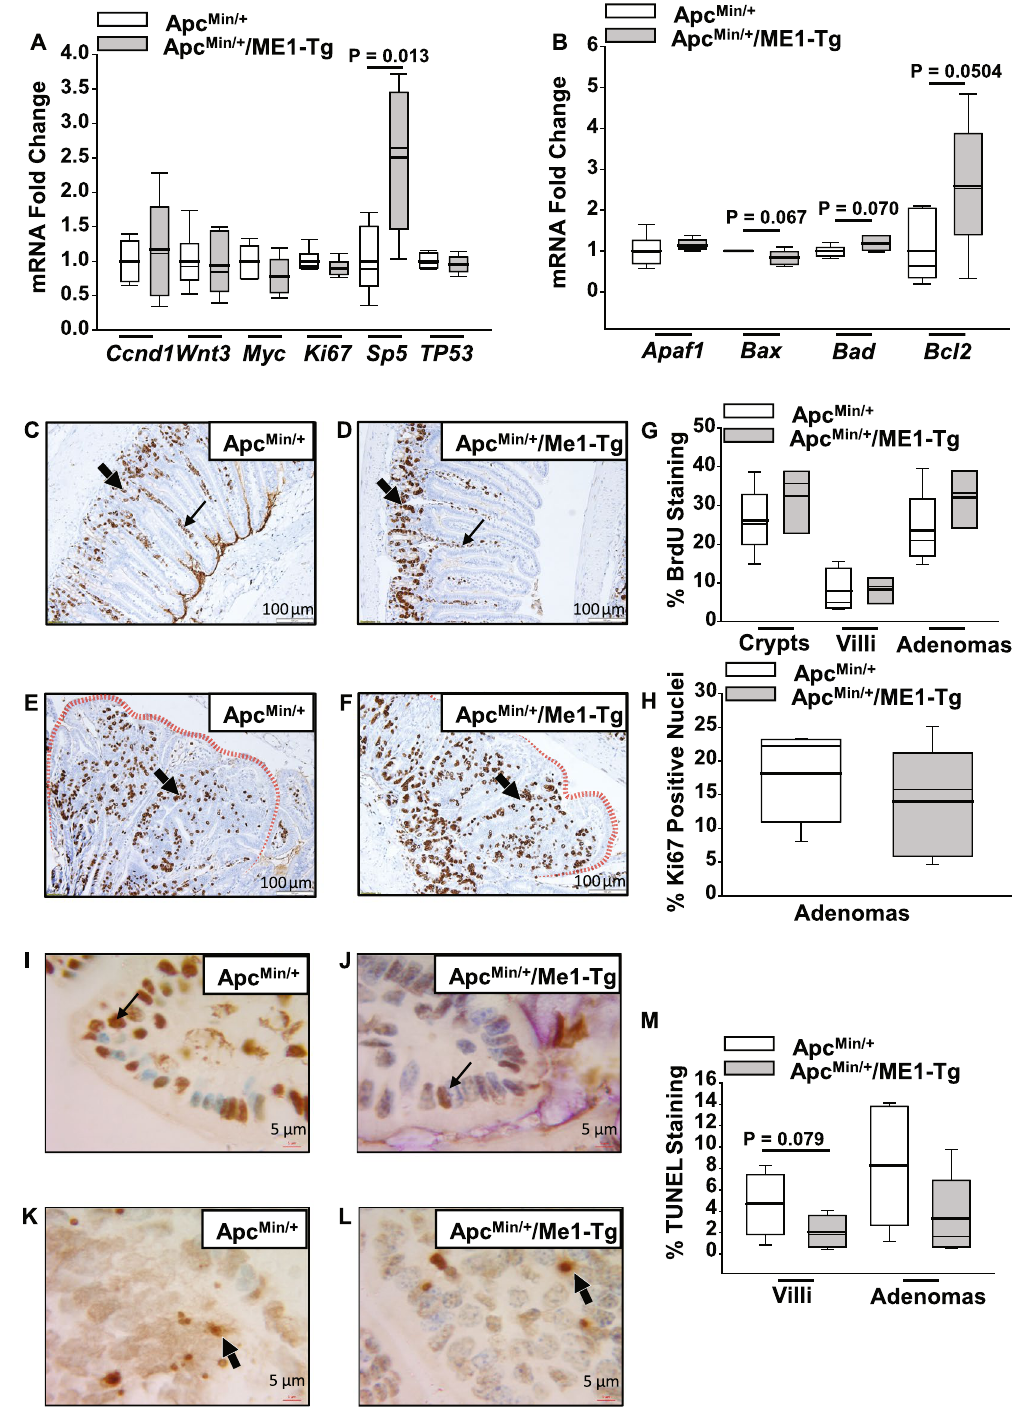
Figure 4. Gene expression, proliferation and apoptosis in experimental mice. ( A ) Fold change of abundance of mRNAs encoding oncogenes and tumor suppressors in jejunums of Apc Min/ + and Apc Min/ + /ME1-Tg male mice (n = 5–6/group). ( B ) Fold change of mRNAs encoding apoptosis-related proteins in mouse jejunums (n = 5–6 mice/group). ( C,D ) Representative images of BrdU-labeled crypts and villi in ilea of male mice. Thin and thick arrows indicate villus and crypt, respectively. ( E,F ) Representative BrdU-labeled/stained adenomas of male mice. Red dotted lines highlight adenoma borders. Arrows indicate adenoma centers (scale bar = 100 μ m). ( G ) Quantification of percentage BrdU-positive cells in ileal crypts, villi, and adenomas of male mice (n = 3–5 mice/group). ( H ) % of cells with nuclear Ki 67 IHC staining in ileal adenomas of male mice (n = 5 mice/group). ( I,J ) TUNEL-positive cells in villi of male Apc Min/ + and Apc Min/ + /ME1-Tg mice, respectively (scale bar = 5 μ m). Arrows identify representative TUNEL-positive cells. ( K,L ) TUNEL-positive cells in ileal adenomas of male Apc Min/ + and Apc Min/ + /ME1-Tg mice (scale bar = 5 μ m). Arrows indicate representative TUNEL-positive cells. ( M ) Quantification of percentage-positive ileal TUNEL staining (n = 5–6 mice/group). Boxes